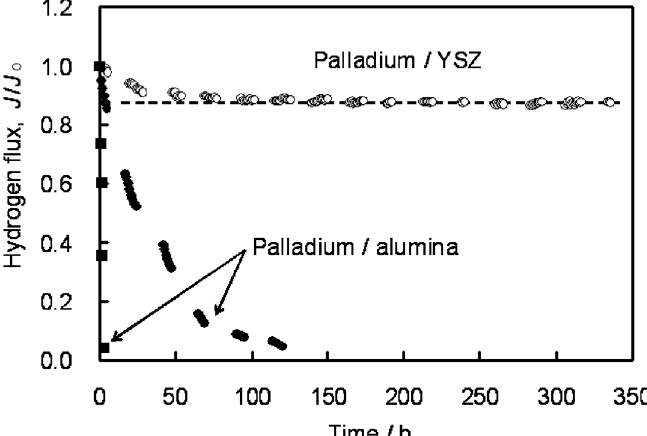
Figure 6. Hydrogen flux measured at 650 °C for Pd-YSZ and PdAl 2 O 3 membranes at 100 kPa of pressure difference. Reprinted from [121] with permission from Royal Society of Chemistry.